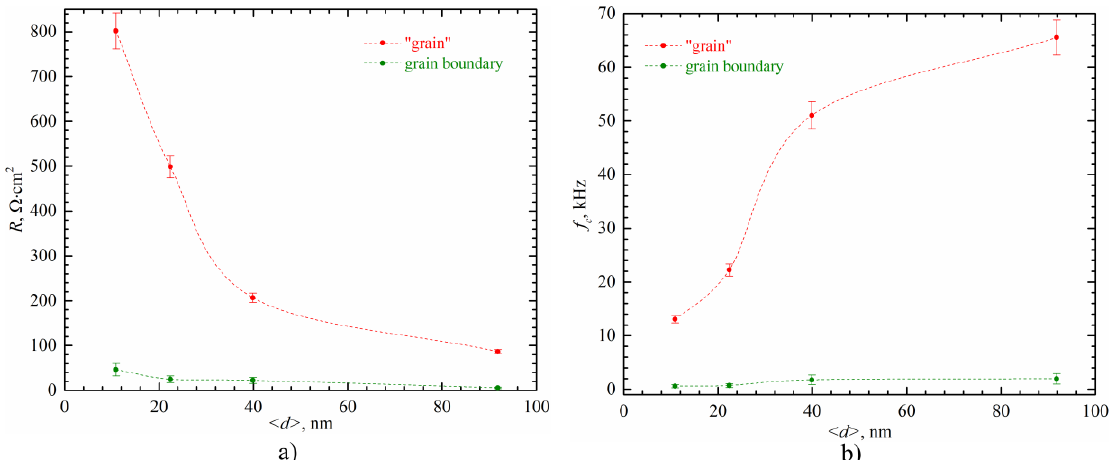
Figure 6. ( a ) Dependencies of normalized resistance ( R ) on crystallite size and ( b ) Dependencies of critical frequency ( f c ) on crystallite size for SDC thin films deposited by evaporating powder of 201.3 m 2 /g specific surface area and with a 0.4 nm/s deposition rate.